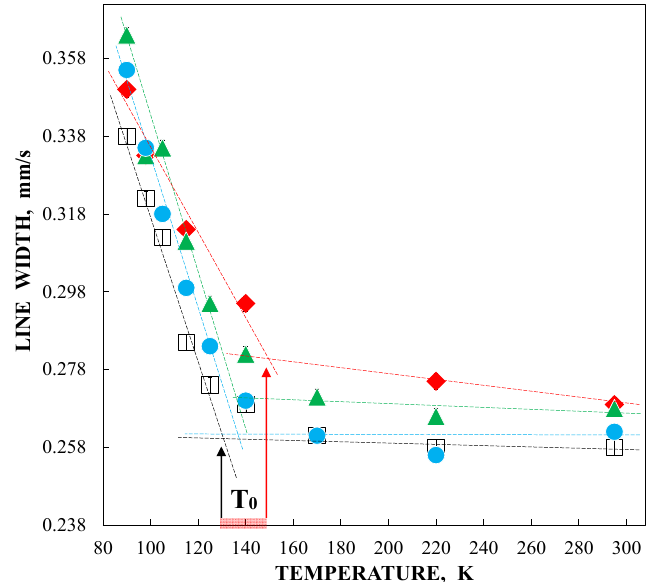
Figure 24. Unusual temperature dependencies of the line widths for the spectral components 1–5 obtained within the new heterogeneous iron core model used for fitting the Mössbauer spectra of ferritin ( ♦ ) and their analogues Ferrum Lek ( □ ), Maltofer ® ( ▲ ) and Ferrifol ( • ). Dashed lines indicate different slopes of the line broadening upper and below so‑called critical temperature T 0 (arrows indicate the range of T 0 for the nanosized iron cores in ferritin and its analogues). Adapted from Ref. [50] with permission from Springer Nature: Hyperfine Interactions, “Unusual temperature dependencies of Mössbauer parameters of the nanosized iron cores in ferritin and its pharmaceutical analogues”, Alenkina I.V., Kuzmann E., Felner I., Kis V.K., Oshtrakh M.I., ©2021.